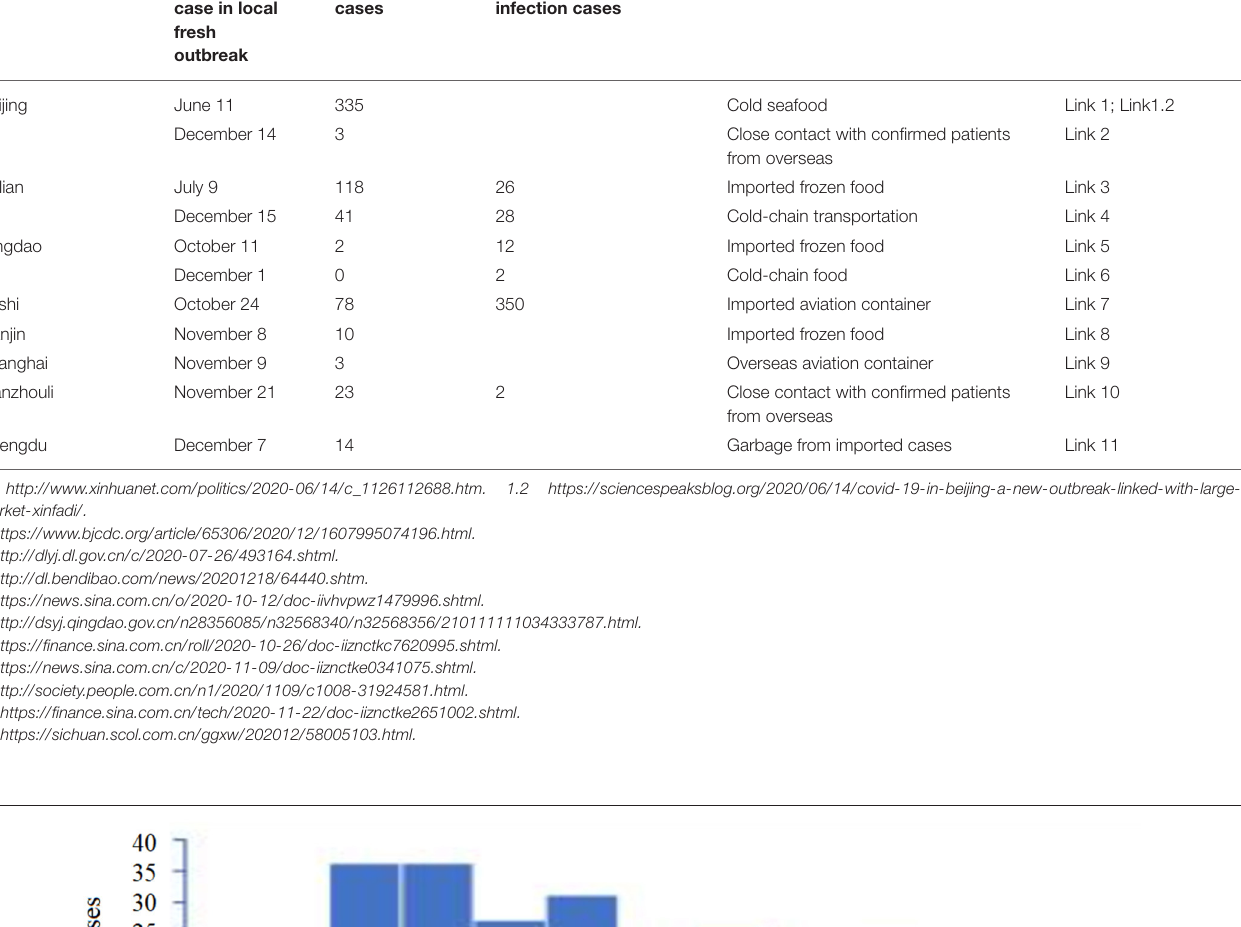
TABLE 1 | Epidemiological data of sporadic COVID-19 outbreaks from June to December 2020 in China. City